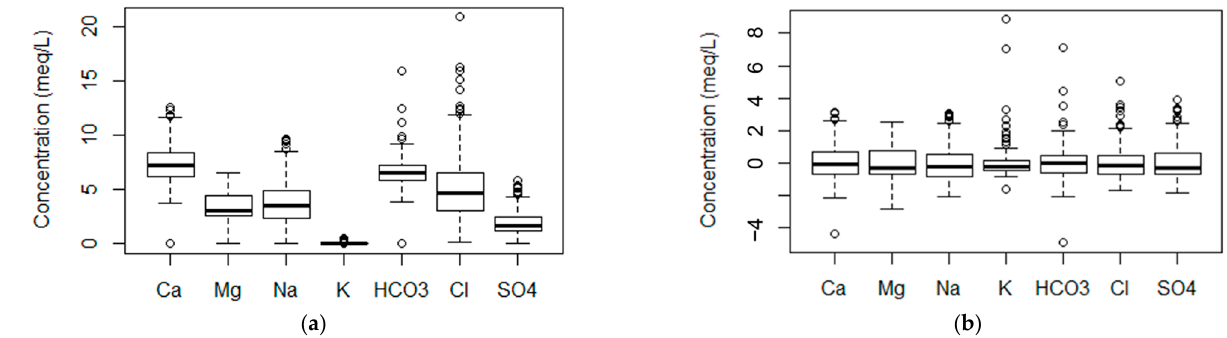
Figure 2. Boxplot of the concentrations of the major ions in meq/L: ( a ) distributions before the standardization; ( b ) distributions after standardization.